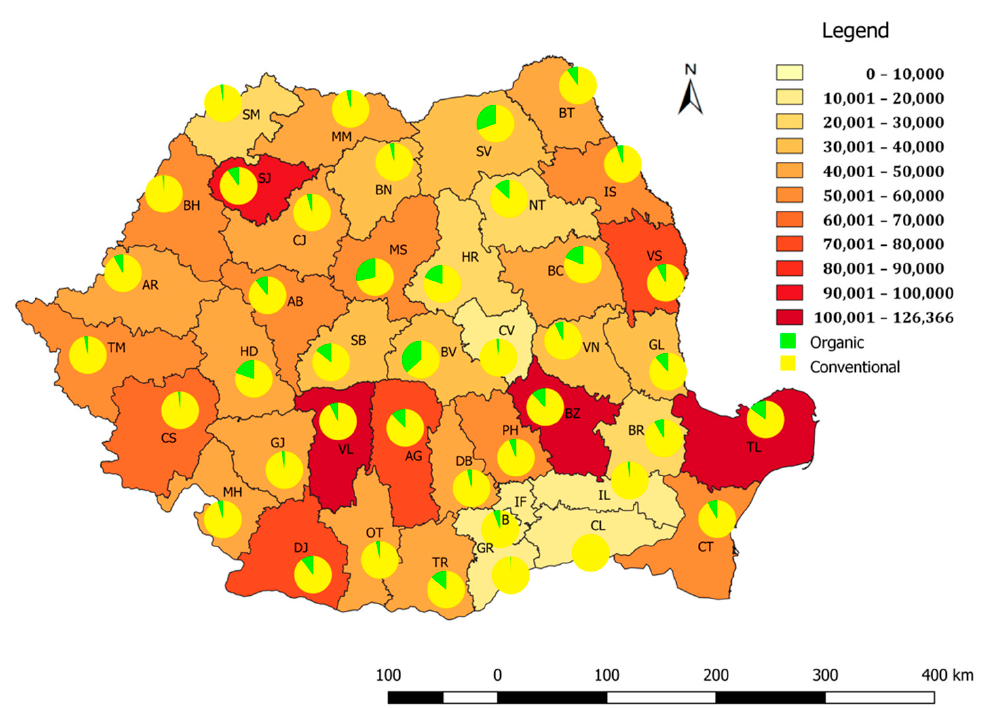
Figure 3. The distribution of beehives in Romania (2019) .